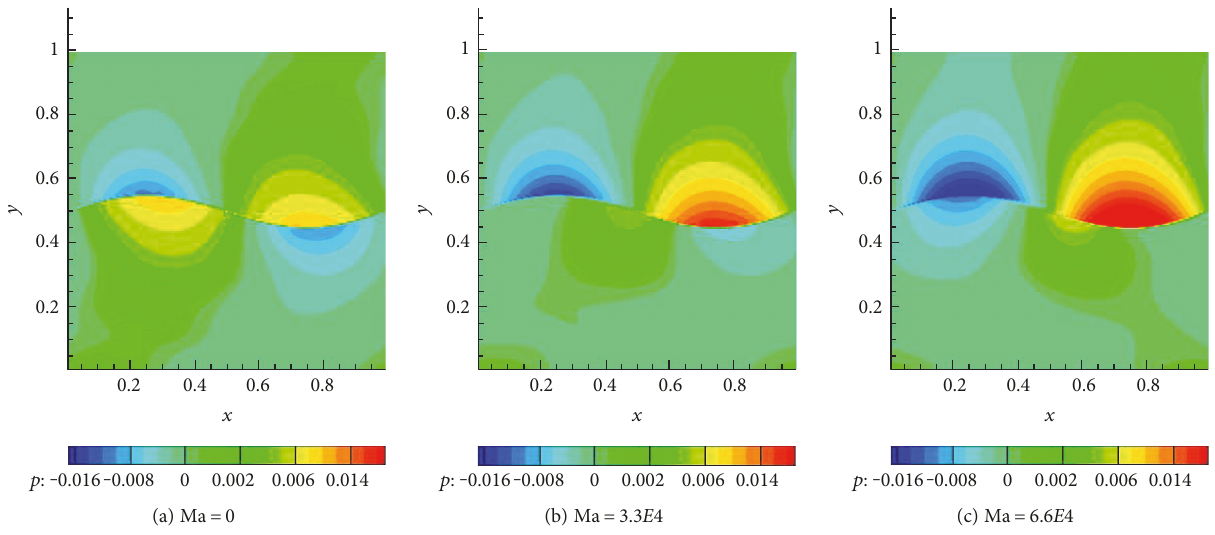
Figure 3: The pressure distribution of the interface at T =0.03 time, Re